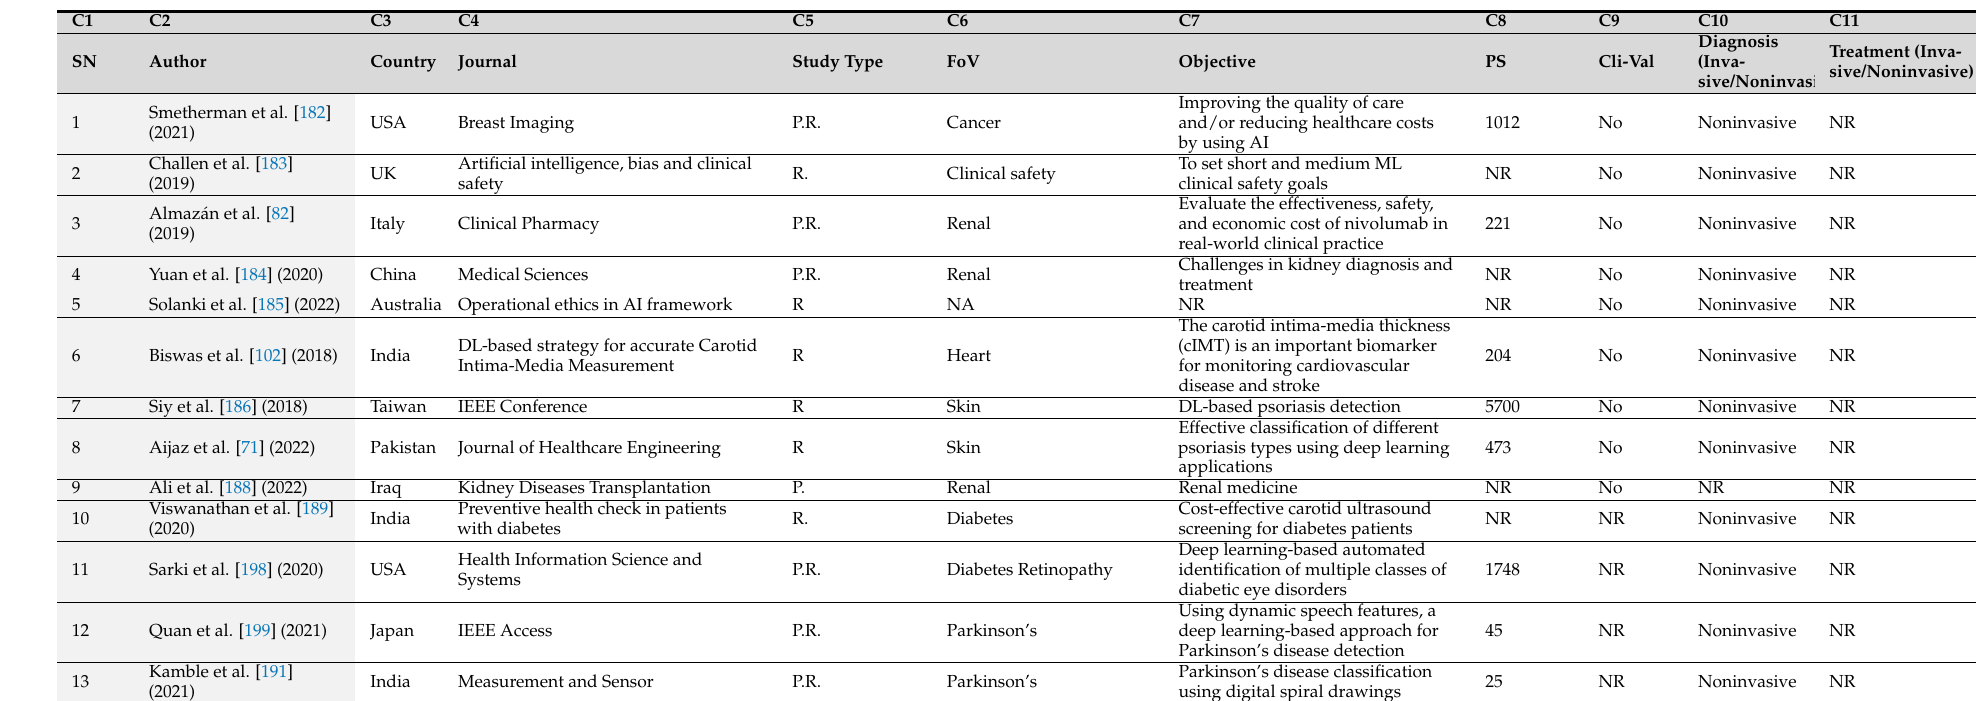
Table 2. Benchmarking of